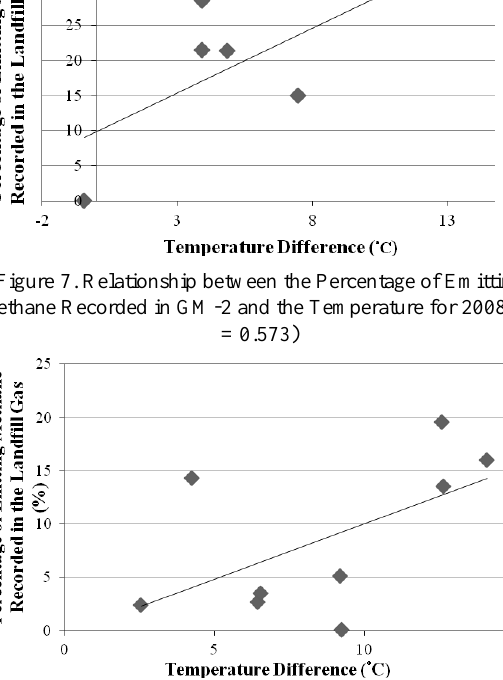
Figure 8. Relationship between the Percentage of Emitting Methane Recorded in GM-17 and the Temperature for 2007 (R 2 = 0.332)